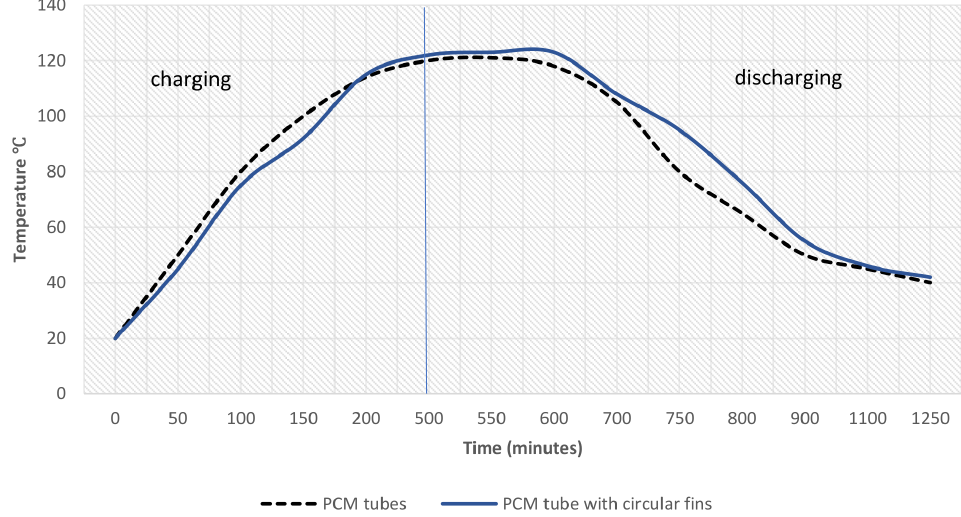
Figure 3. Temperature curves of two experimental tube configurations